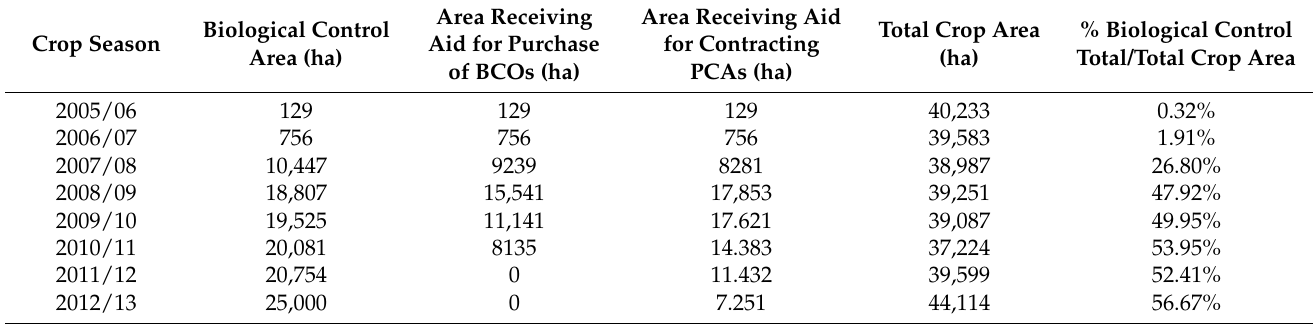
Table 7. Evolution of greenhouse crop area in Almer í a with biological control since 2005/06 to